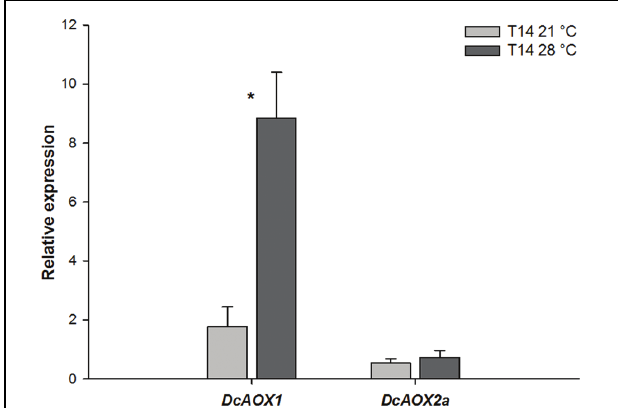
FIGURE 3 | Transcript levels of DcAOX1 and DcAOX2a in primary cultures from secondary phloem of carrot roots grown at different temperatures. The expression was normalized with DcEF1 α . T14–21 ◦ C: explants after 14 days in culture, growing at 21 ◦ C; T14–28 ◦ C: explants after 14 days in culture, growing at 28 ◦ C. T0 (explants before inoculation) was used as calibrator. Data are the mean values ± SE of five individual plants. Student’s t -test was applied to test differences between temperatures for each gene. Significant differences are marked with ∗ .